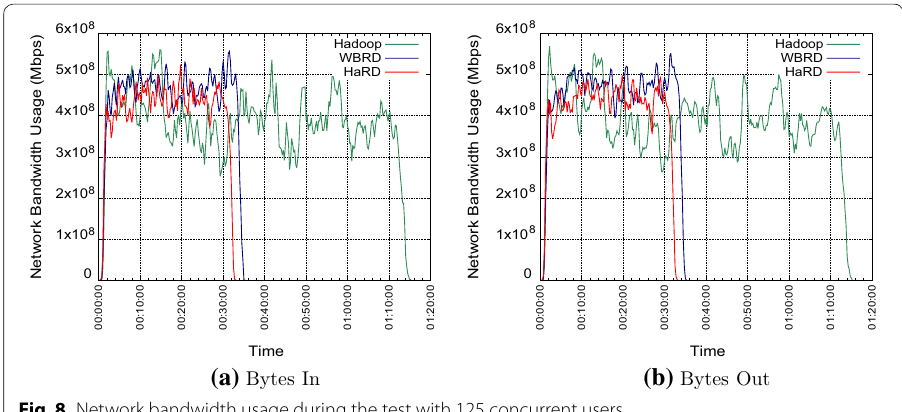
Fig. 8 Network bandwidth usage during the test with 125 concurrent